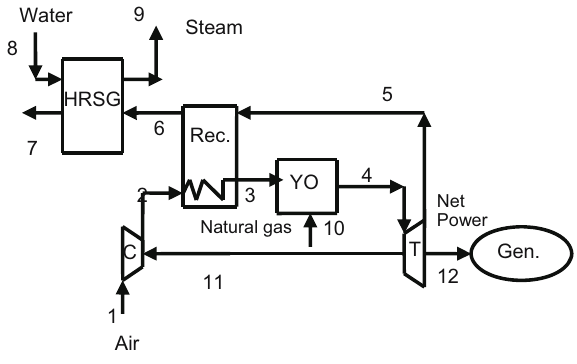
Figure 2: The general diagram of the air heating cogeneration system ( airh )